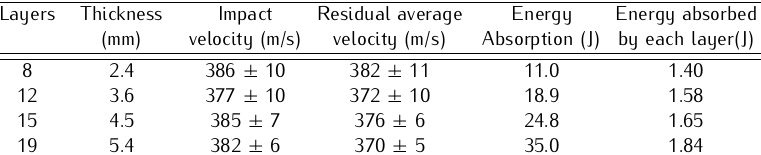
Table 3. Initial and residual velocities for laminates of 0/90/30/-60 lay-up sequence.